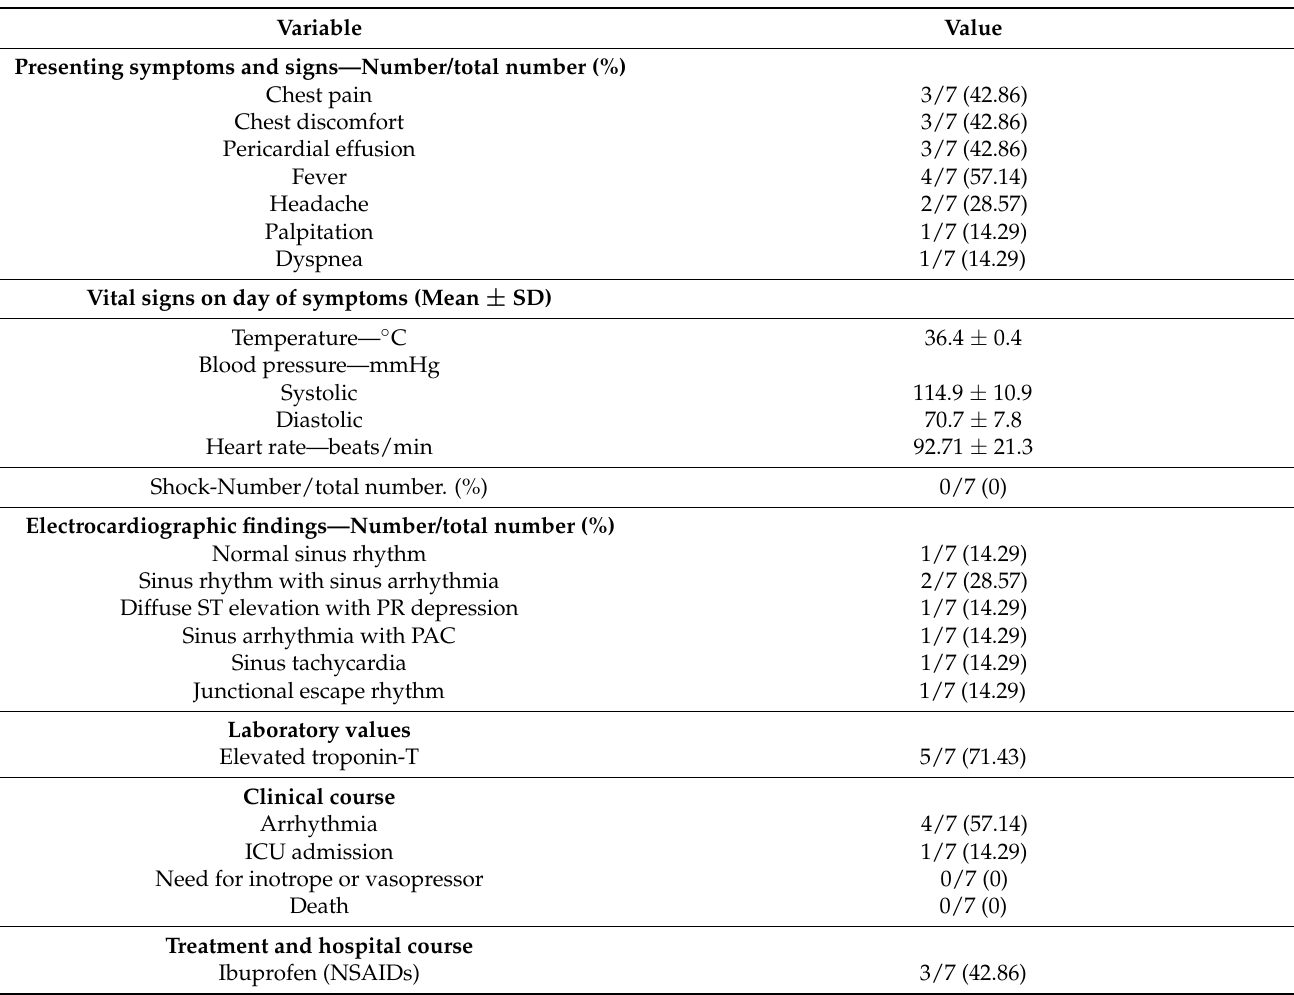
Table 2. Presentation with myopericarditis, subclinical myocarditis, and pericarditis after second dose